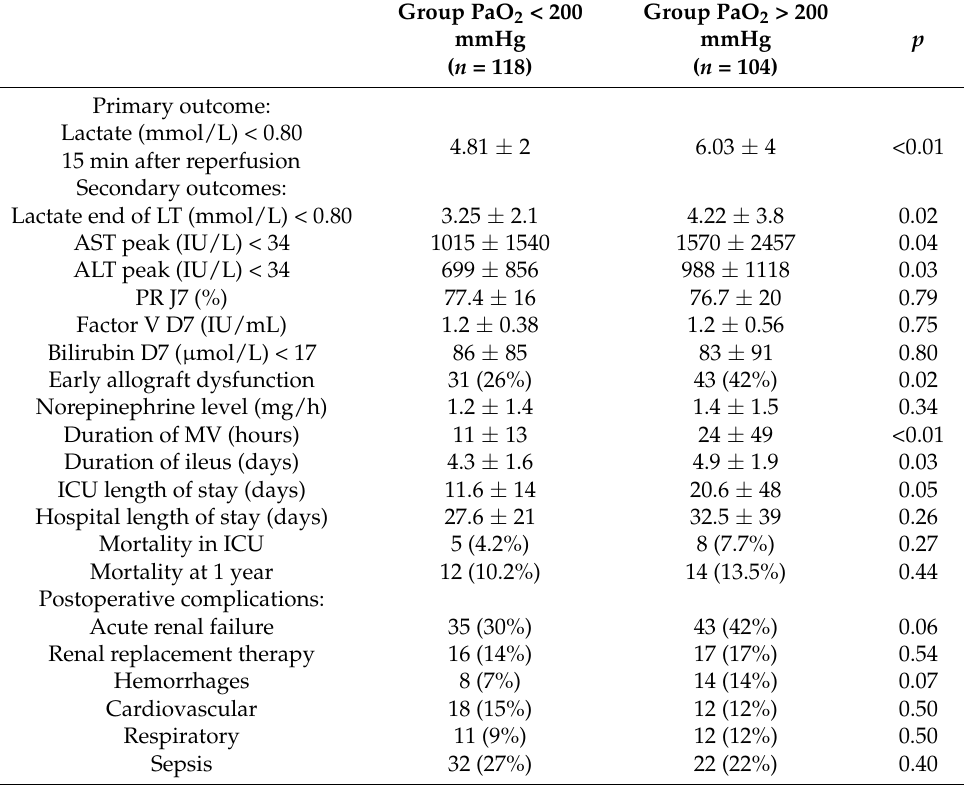
Table 4. Perioperative and postoperative